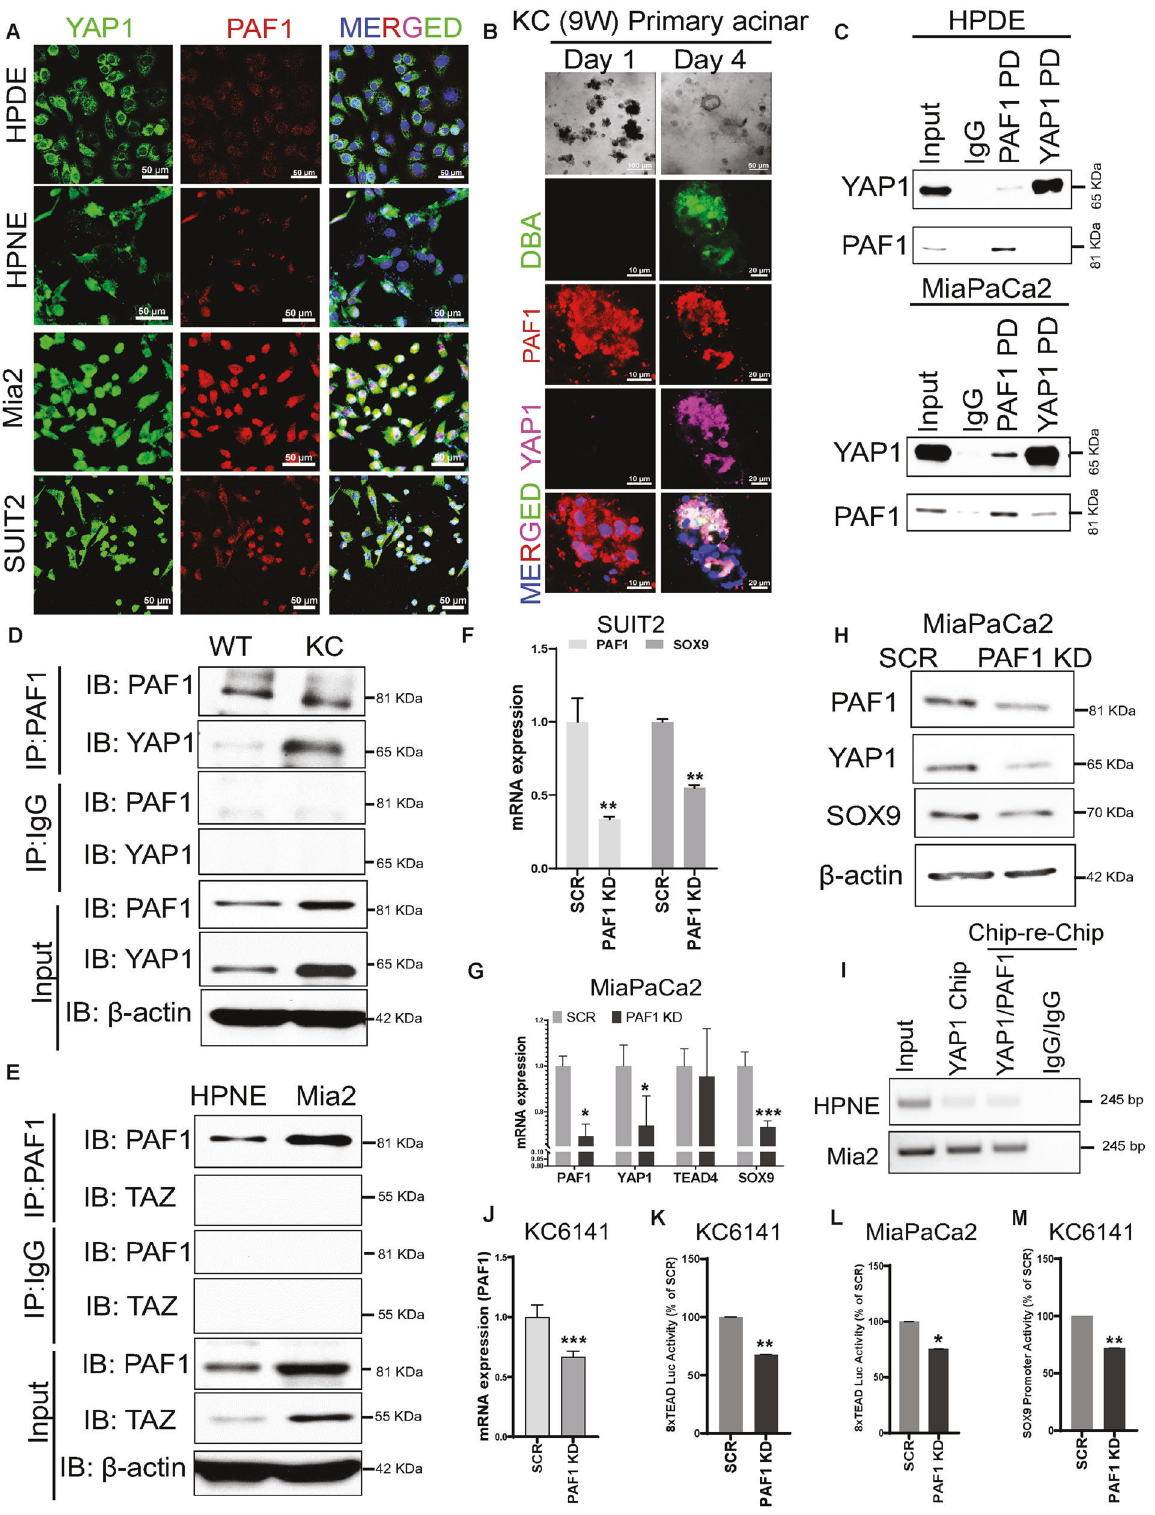
Treatment with inhibitors of YAP/TEAD transcriptional activity reduces PAF1 and decreases cancer stem cells, cell viability, proliferation, and colony formation in PC CA3, an inhibitor of YAP/TEAD transcriptional activity, inhibits the proliferation and metastasis of other cancers [15, 16];